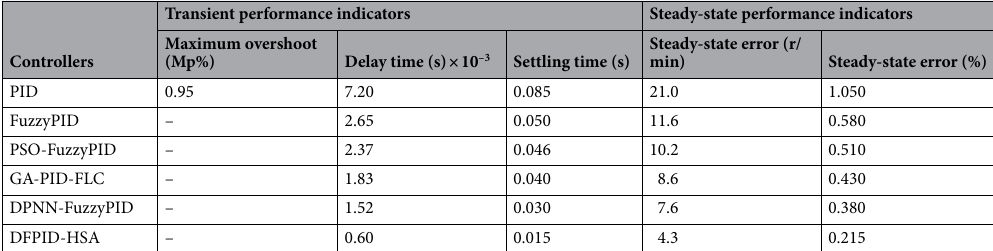
Table 9. The comparison of performance indicators under the variable load